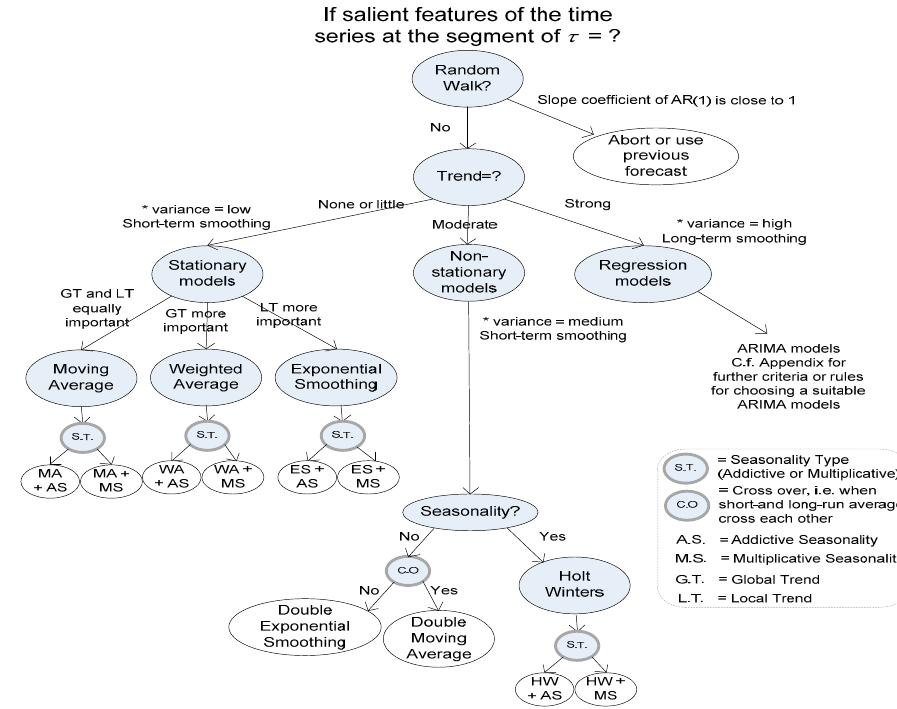
Figure 3. Decision graph for selecting an appropriate curve-fitting method for shadow feature generation.